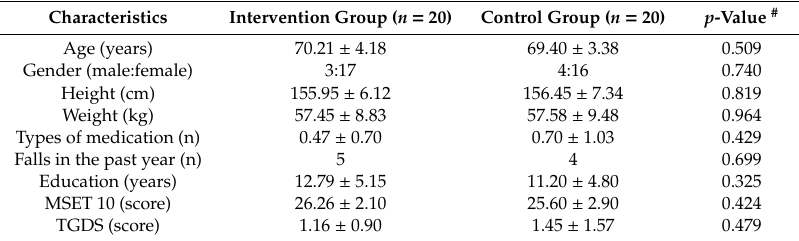
Table 2. Participant demographic characteristics.